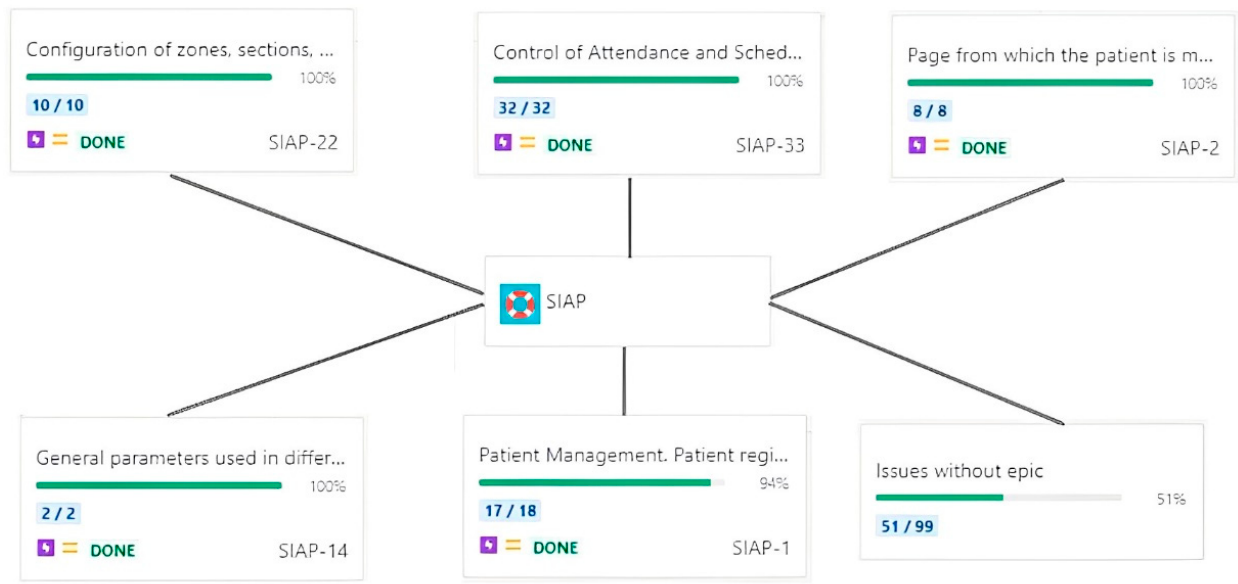
Figure 6. JIRA- Project Epic Map.